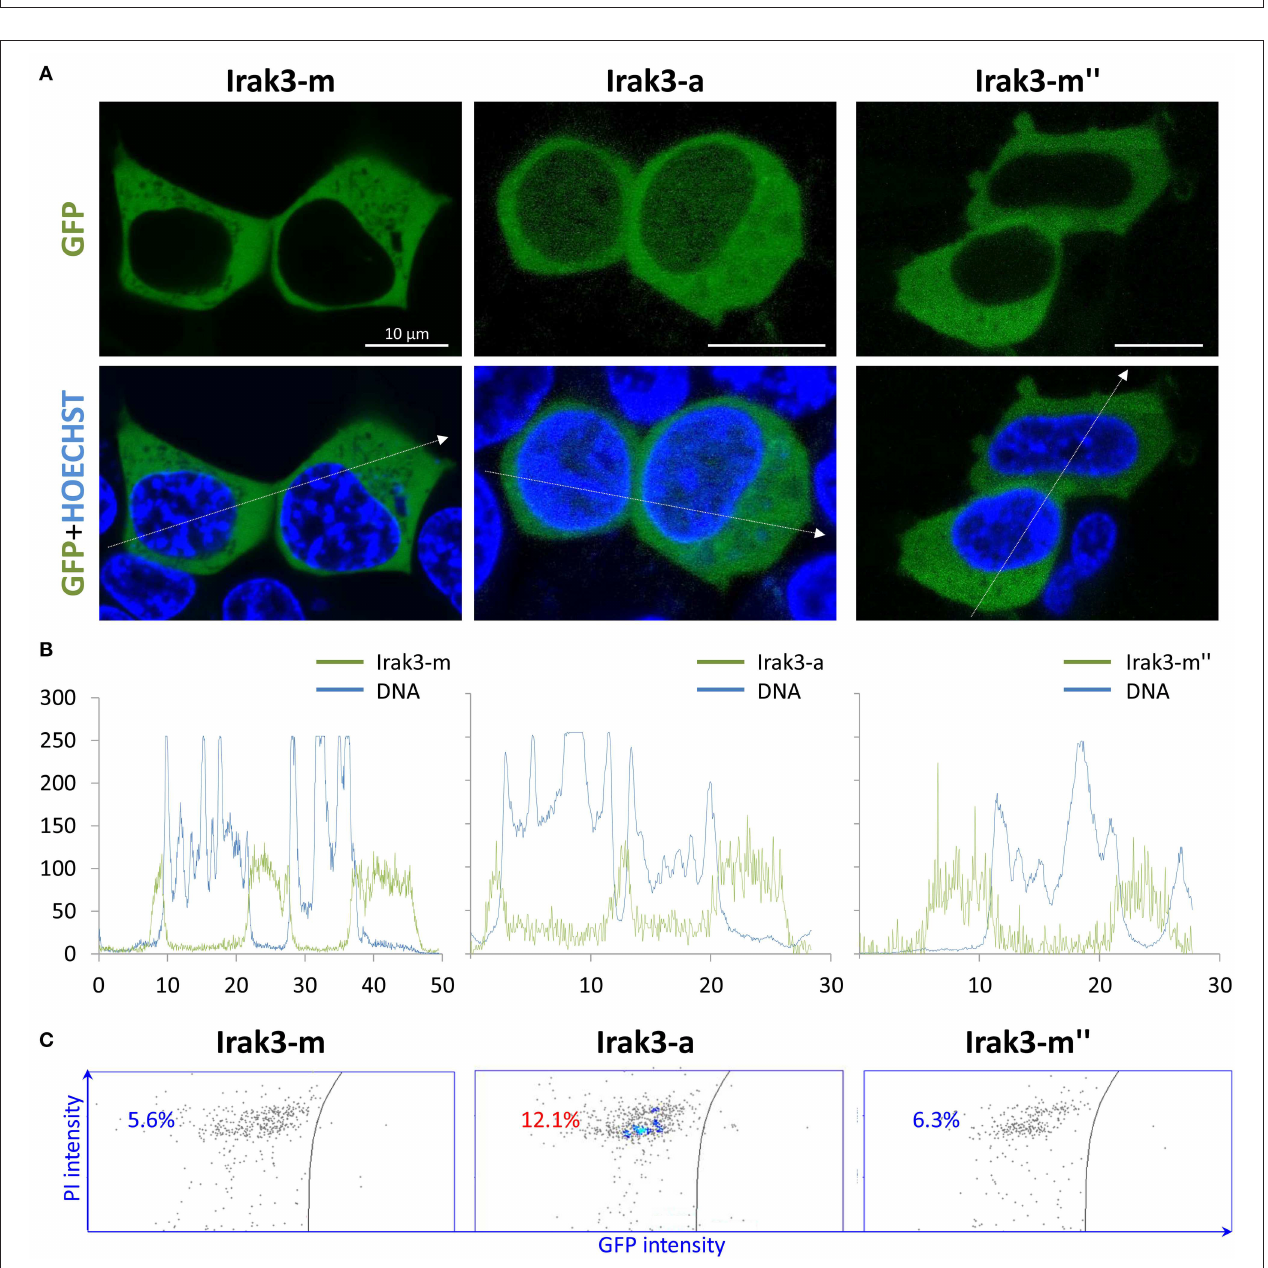
FIGURE 4 | ( p < 0.05) are marked with an asterisk (*); error bars indicate SEM. (B) The HeatMap illustrates the averaged fold-change values (according to the legend on the right) of the mRNA concentrations measured in the liver (left panel), head kidney (central), and PBLs (right) at the time points after infection indicated below the scheme relative to controls (set as 1.0). The quantified transcripts are listed as gene symbols on the left and categorized according to their affiliation to immune processes; orthologs whose expression is IRAK3-dependent in mammals according to Zhou et al. (5) are marked in red. Significant copy-number changes ( p < 0.05) are underlined. All expression values were normalized against the geometric means of the reference genes eef1a1 and rps5 as evaluated with the qBase + software.